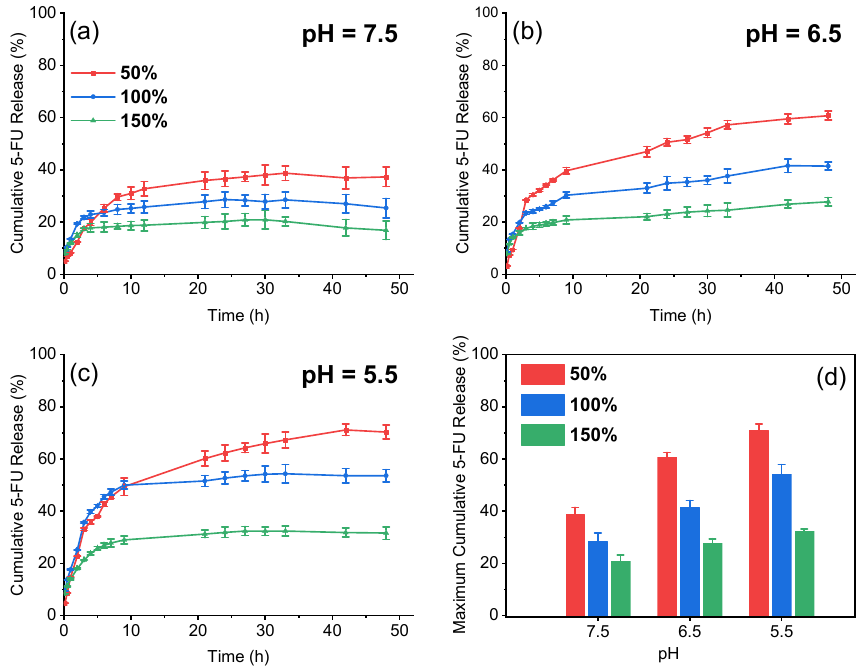
Figure 5. Release profiles of MC/M/H-B4 nanogels ( a – c ) and the maximum cumulative 5-FU release from nanogels with different drug dosages at different pH values ( d ).